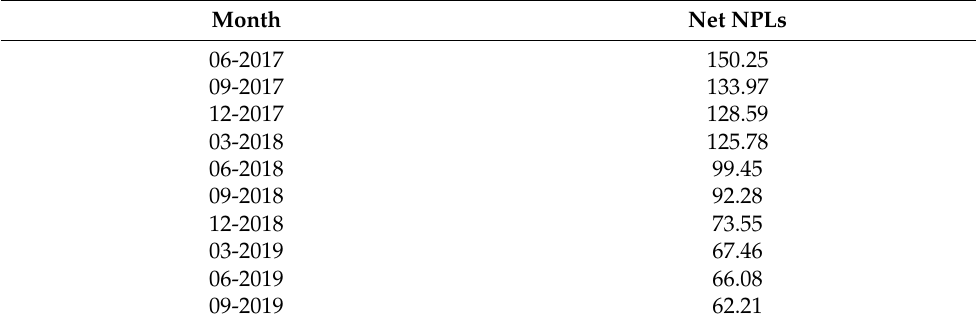
Table 5. Net nonperforming loans in Italy, in billions of euros (June 2017–September